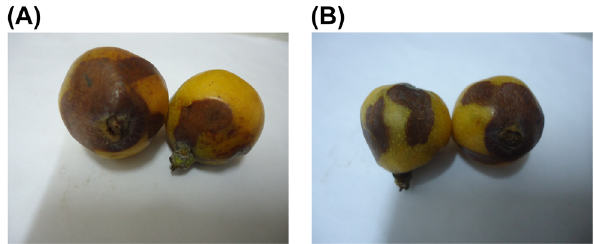
Figure 1: Symptomology of fruit rot of loquat associated with Alternaria